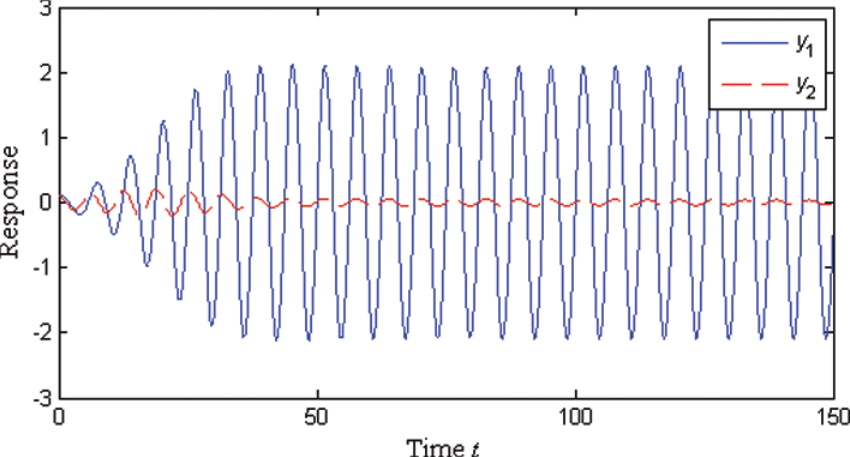
Fig. 11. Time history without feedback